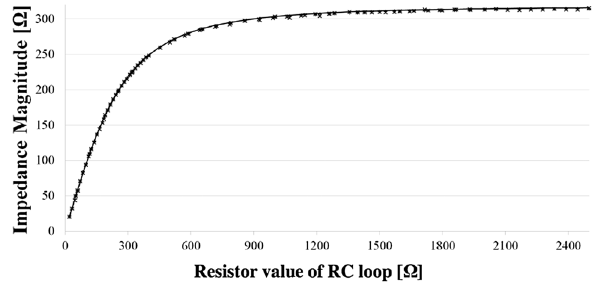
Figure 3. Impedance magnitude at 1 kHz at varying the resistor value of the RC loop: theoretical trend (continuous line), insulin meter ( × ), and reference LCR Meter